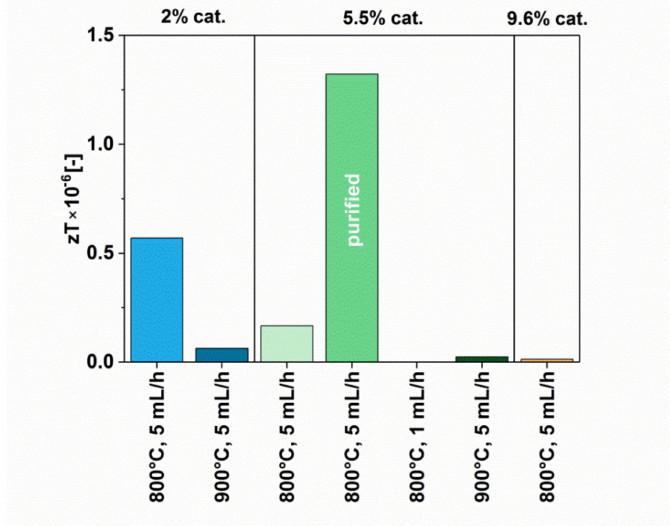
Figure of Merit of MWCNTs synthesized using di ff erent parameters (with and without